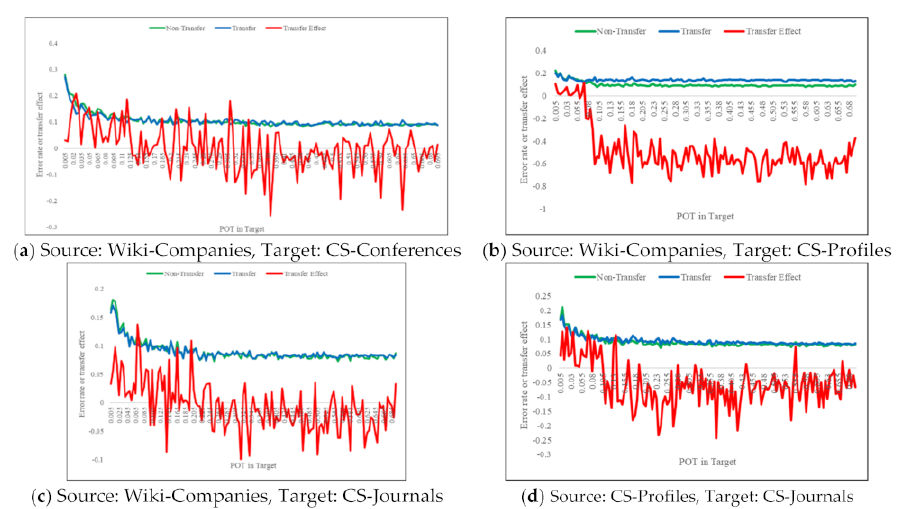
Figure 6. The relationship between the training set division and transfer effect in positive transfer.